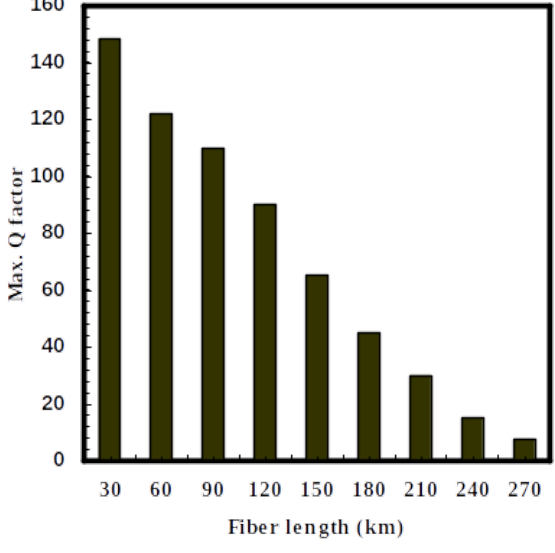
Figure 8: Max Q-factor versus fiber optic cable length for the pro- posed